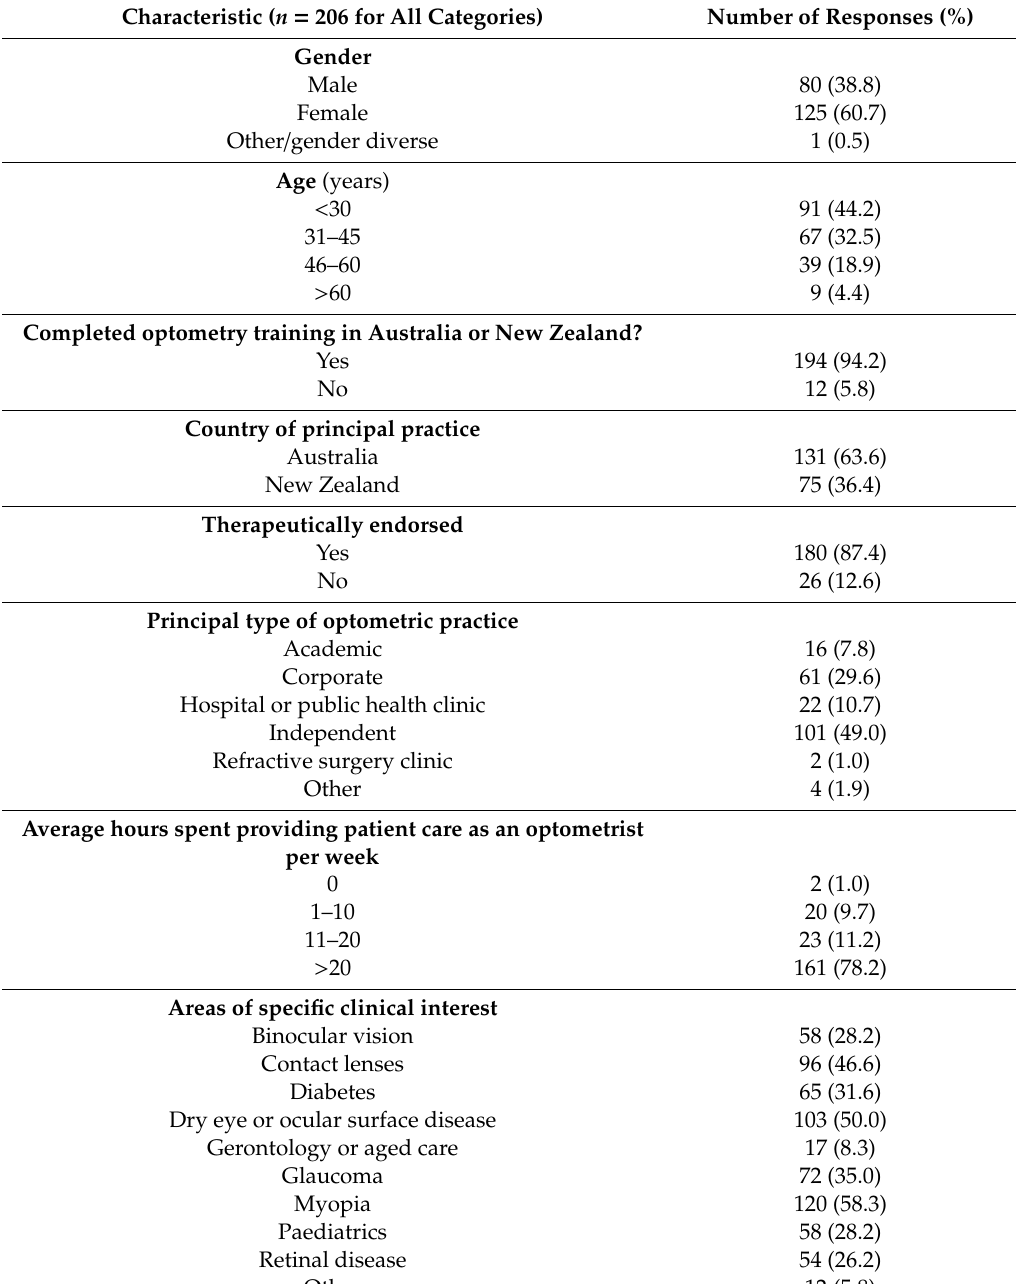
Table 2. Summary of participant